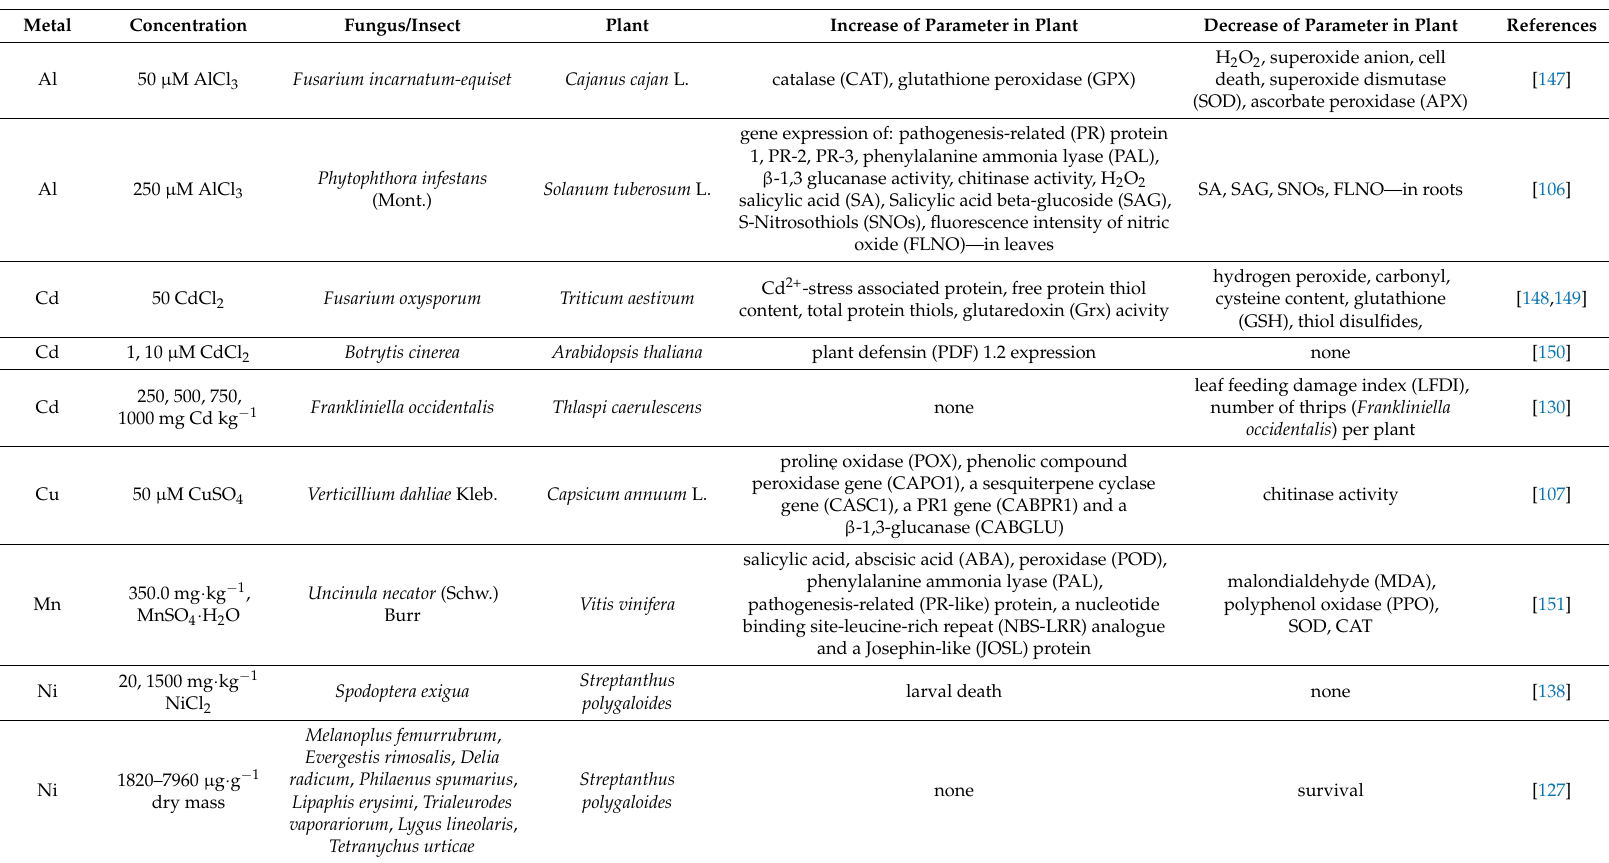
Table 1. Effects of heavy metals on the metabolic status of plants and cross talk of heavy metals and biotic